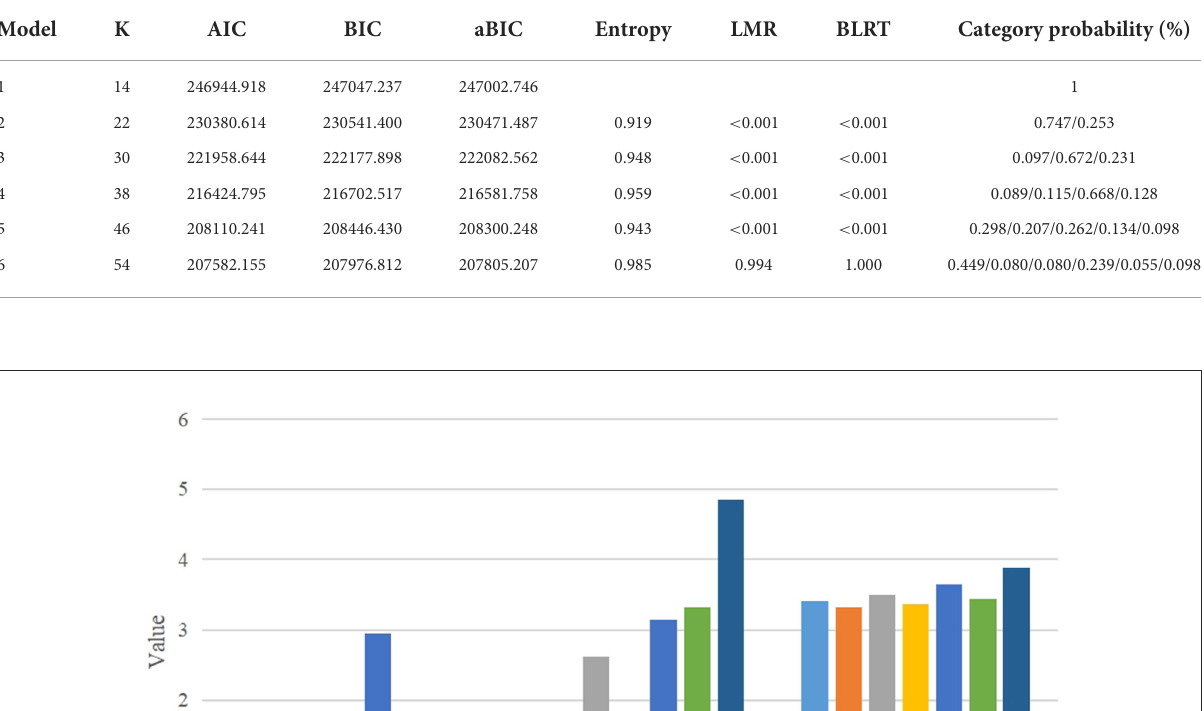
TABLE 1 Potential profile model fitting indicators of media usage types.